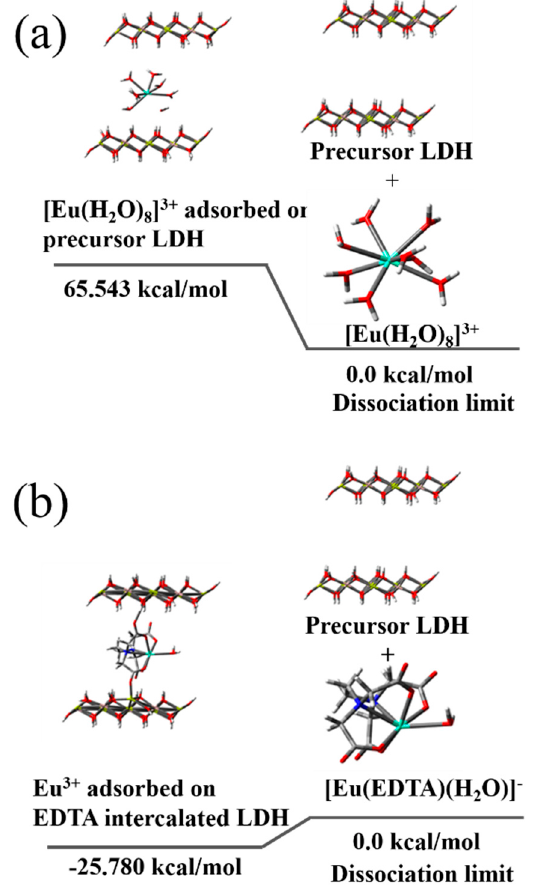
Figure 9. Relative energies of ( a ) [Eu(H 2 O) 8 ] 3 + adsorbed on precursor LDH and ( b ) Eu 3 + adsorbed on EDTA-intercalated LDH.